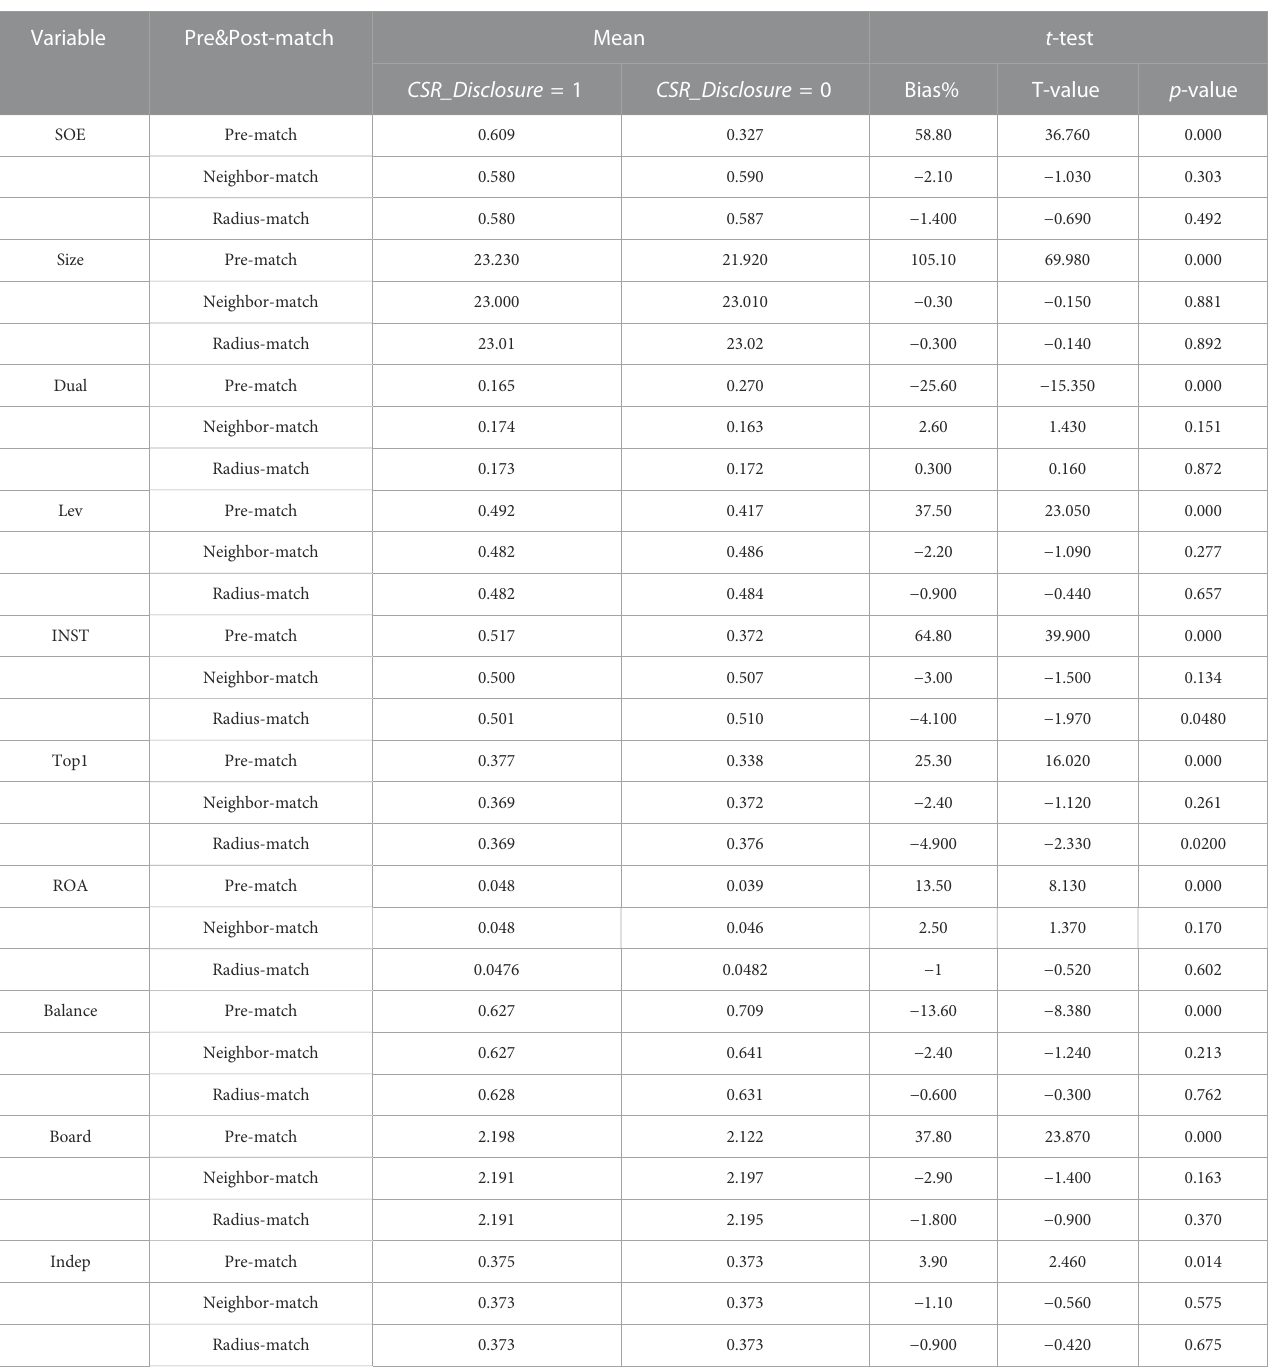
TABLE A2 The balance test results of PSM.